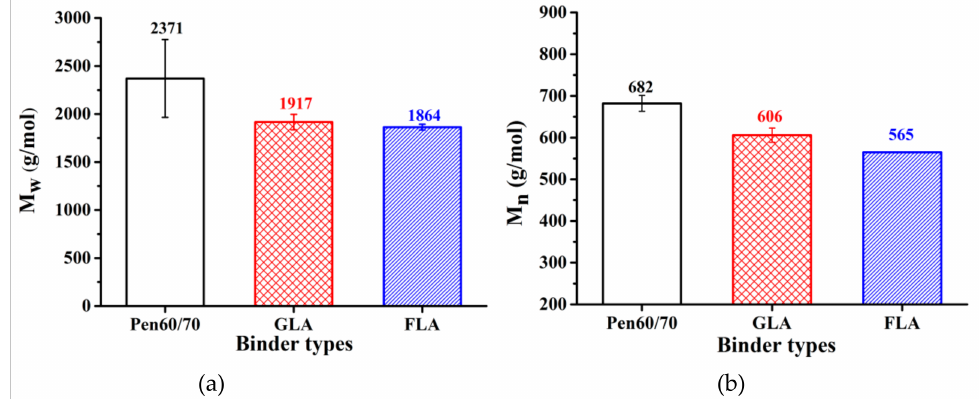
Figure 9. GPC result analysis: ( a ) weight-average molecular weight and ( b ) number-average molecular